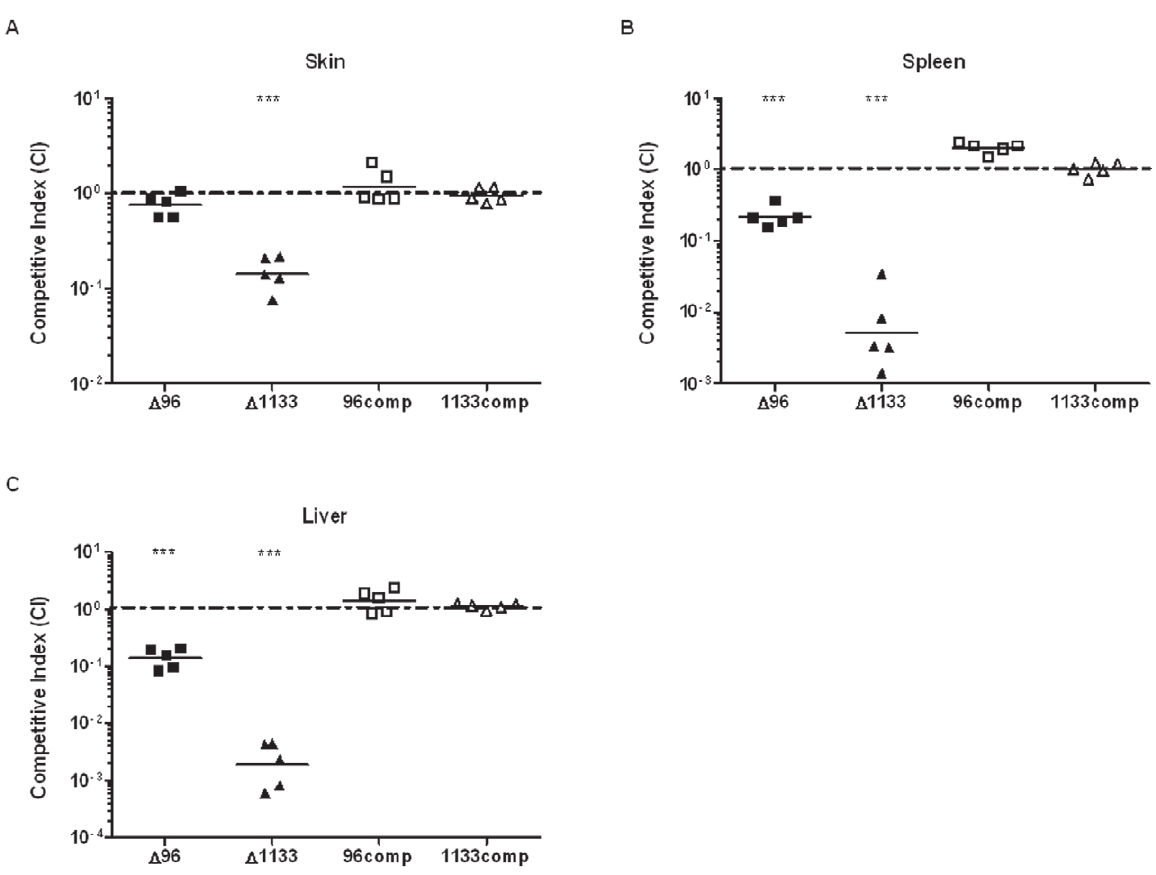
Figure 2. FTN_0096 and FTN_1133 deletion mutants are attenuated for virulence invivo . Mice were subcutaneously infected with a 1:1 mixture of wild-type F. novicida and either D 96 or D 1133 (10 5 CFU each) or respective complemented strains. Forty-eight hours after infection, organs were harvested, CFU enumerated, and the competitive index (CI) calculated for the skin at the site of infection (A), spleen (B), and liver (C). CI = (CFU mutant output/CFU WT output)/(CFU mutant input/CFU WT input). Bars represent the geometric mean CI values from each group of mice (n=5). CI values below 1 (dashed line) indicate attenuation of the mutant strain. Data shown is representative of two independent experiments. Asterisks indicate significance as compared to a CI value of 1. (***) p , 0.0005.